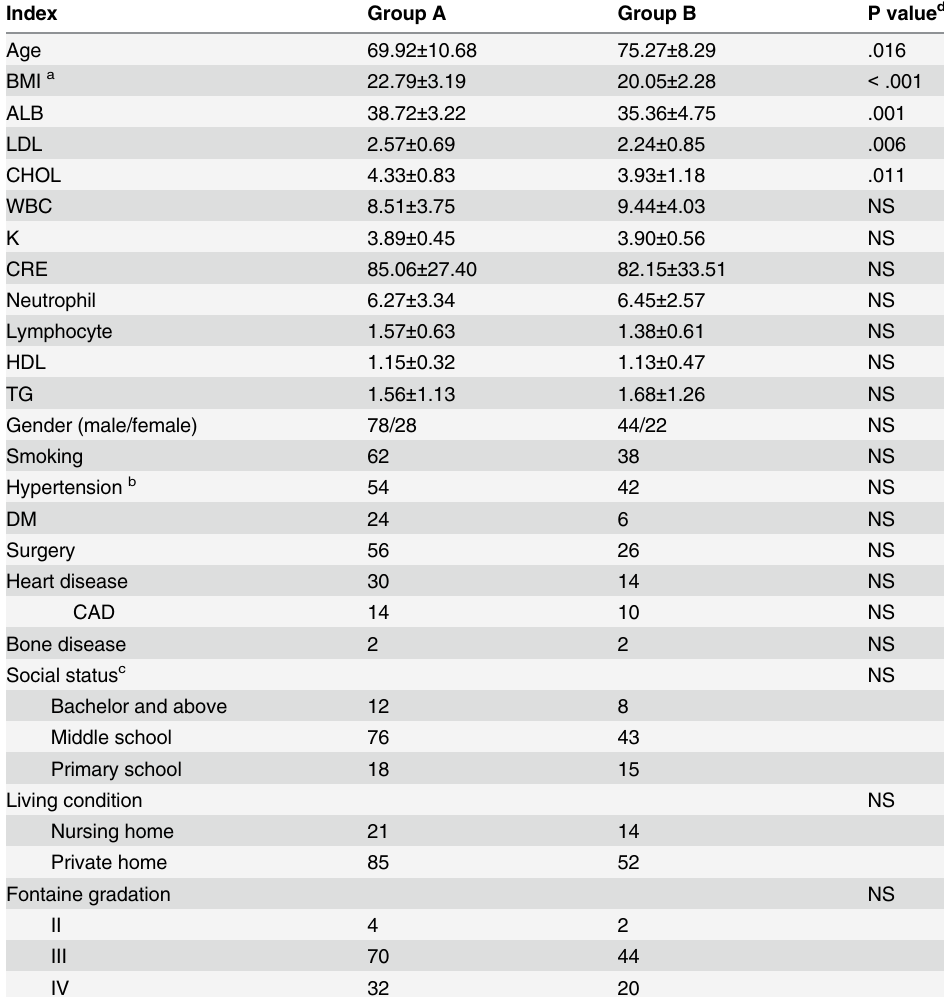
Table 1. Baseline comparison between group A and